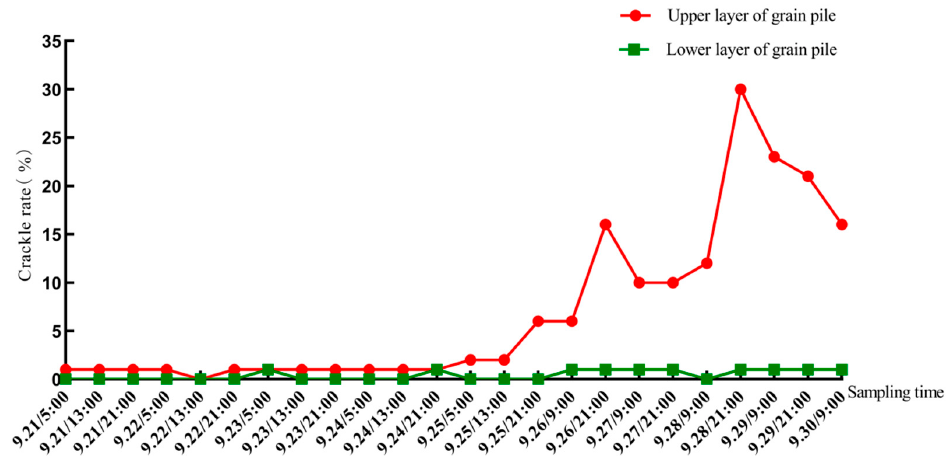
Figure 6. Change curve of the cracking rate of grains not dried sufficiently quickly.